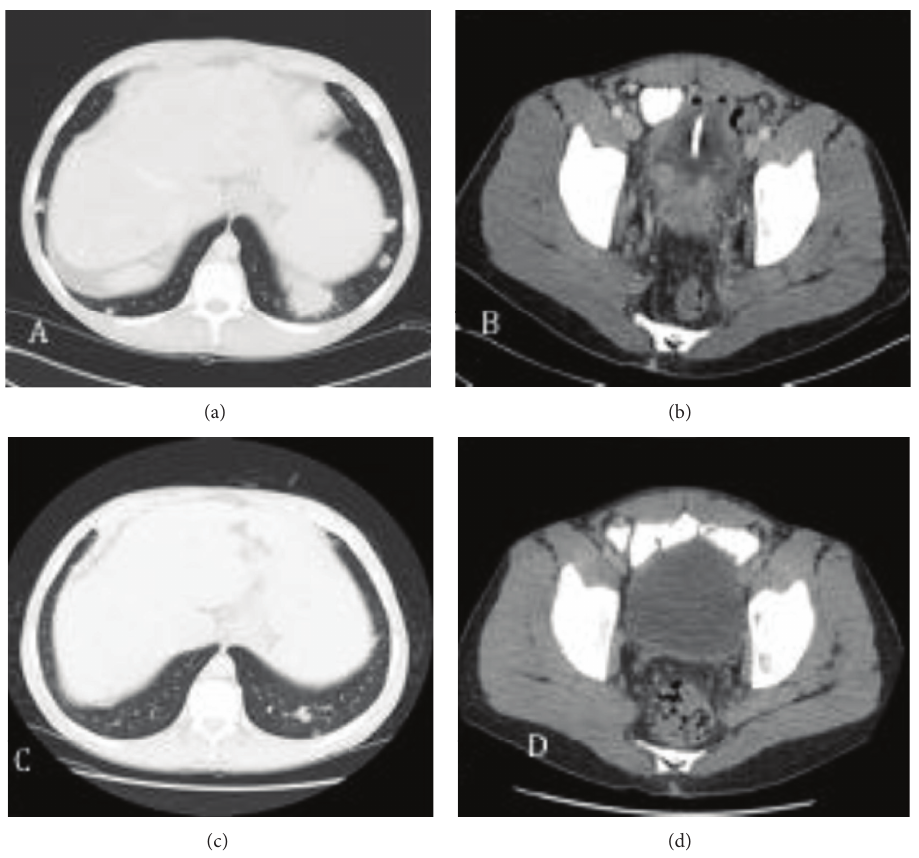
Figure 1: CT scans showing dominant pulmonary nodule in left lower lobe and bladder thickening, pre-chemotherapy (panels A and B), and two months after completion of chemotherapy (panels C and D). These scans demonstrate the stability of the pulmonary nodules, and resolution of the pelvic mass and lymphadenopathy and his subcutaneous